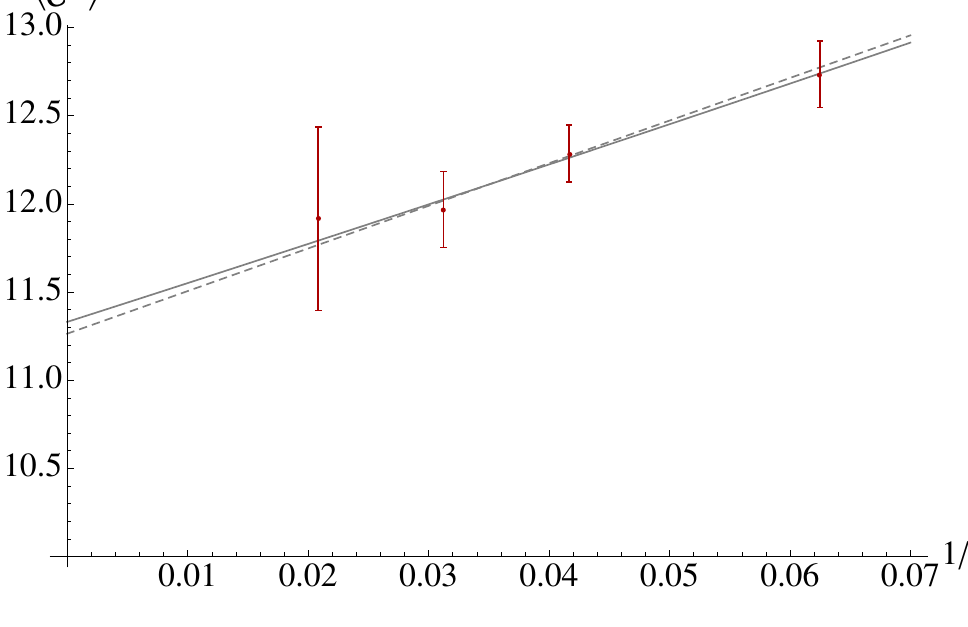
Figure 2 . The red bars correspond to measurements at (cid:3) = 16, 24, 32 and 48 for T = (cid:21) 1 = 3 and N = 10. The dashed gray line represents the linear extrapolation, and the solid gray curve corresponds to the quadratic extrapolation.